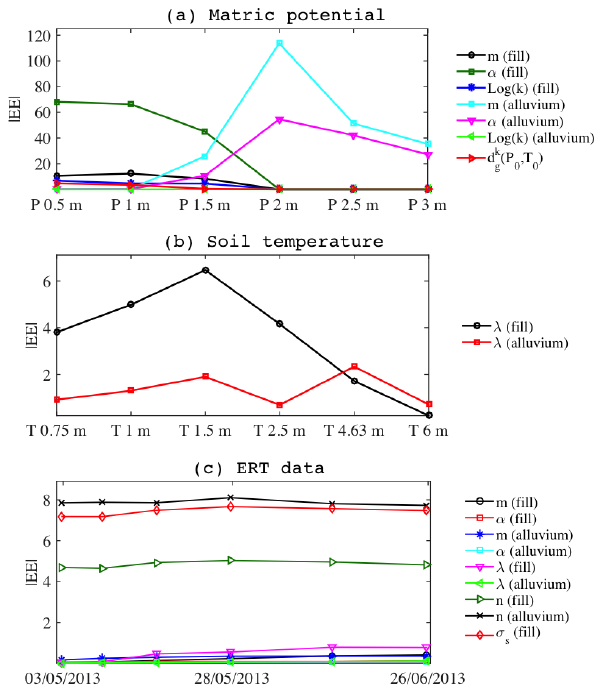
Figure 4. The sensitivity coefficients | EE | of matric potential, sub- surface temperature and apparent-resistivity data with respect to dif- ferent hydrological, thermal and petrophysical parameters. A pa- rameter with a higher | EE | is more likely to be determined. (a) The sensitivity coefficient | EE | of the matric potential at depths of 0.5, 1, 1.5, 2, 2.5 and 3m, with respect to the hydrological parameters of the fill and alluvium layers, and the gas diffusion coefficient stan- dard conditions. (b) The | EE | of the temperature at depths of 0.75, 1, 1.5, 2.5, 4.63 and 6m, with respect to the thermal conductivity of fill and alluvium layers. (c) The temporal variations of the | EE | of the resistivity data with respect to the soil hydrological-thermal and petrophysical parameters of both fill and alluvium